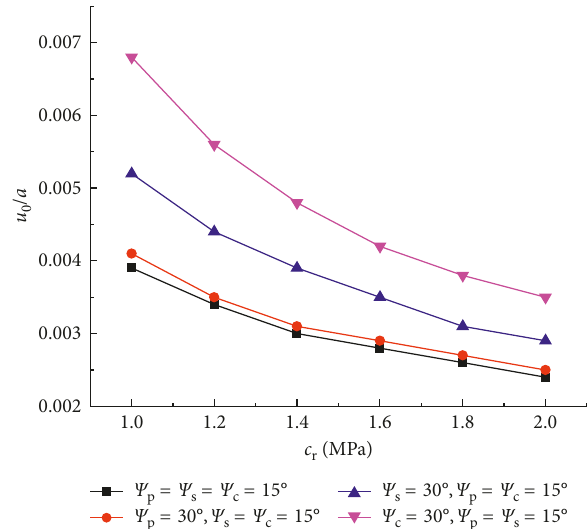
Figure 9: The values of u